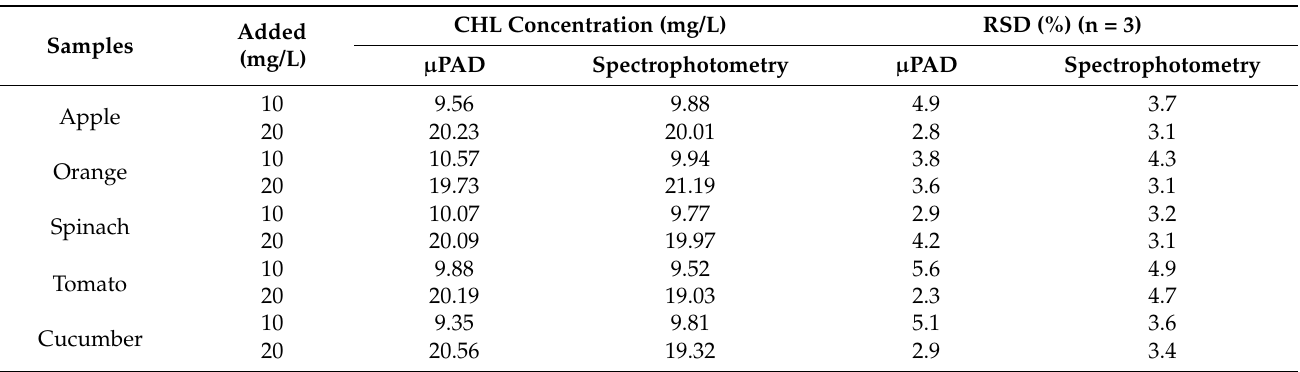
The detection of CHL in five fruit and vegetable samples by pSBMA- µ PAD and UV–visible spectrophotometry.